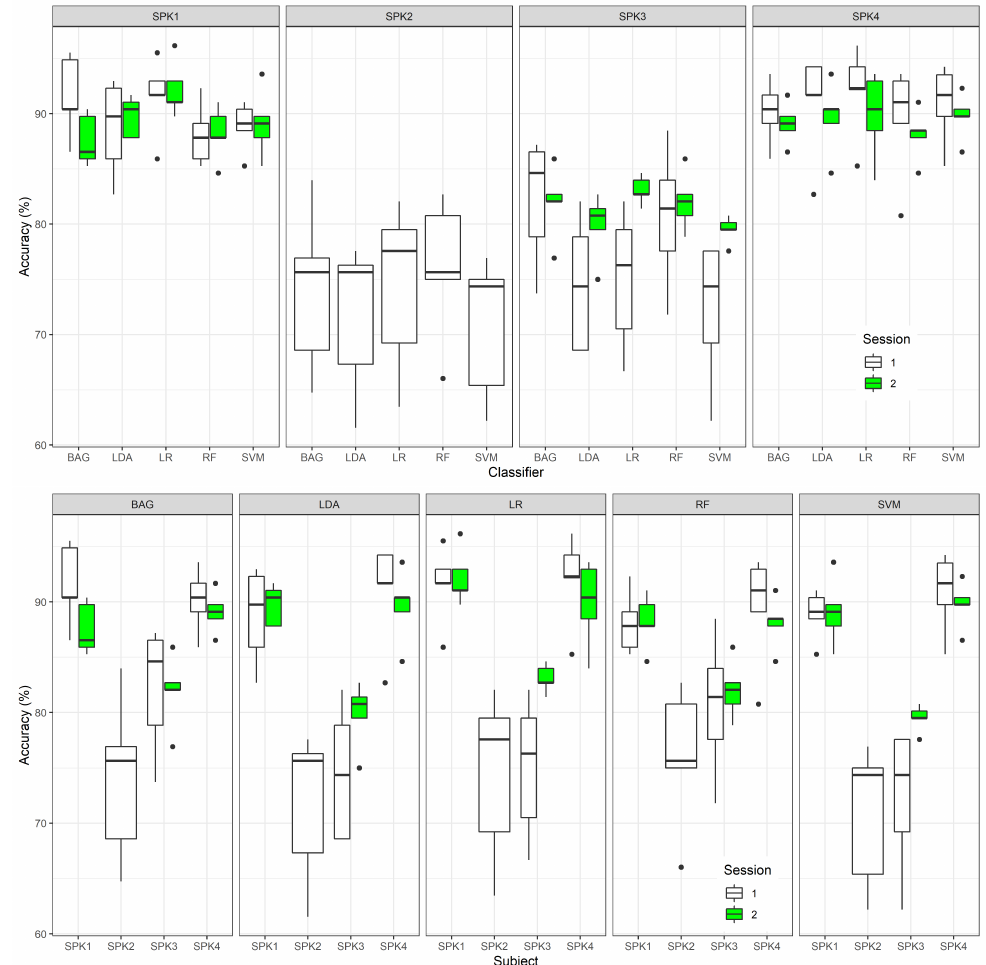
Figure 4. Boxplot representations depicting the average classification accuracies obtained for each ac- quisition session: average accuracies per classifier ( top ) and average accuracies per speaker ( bottom ). Speaker 2 only recorded one